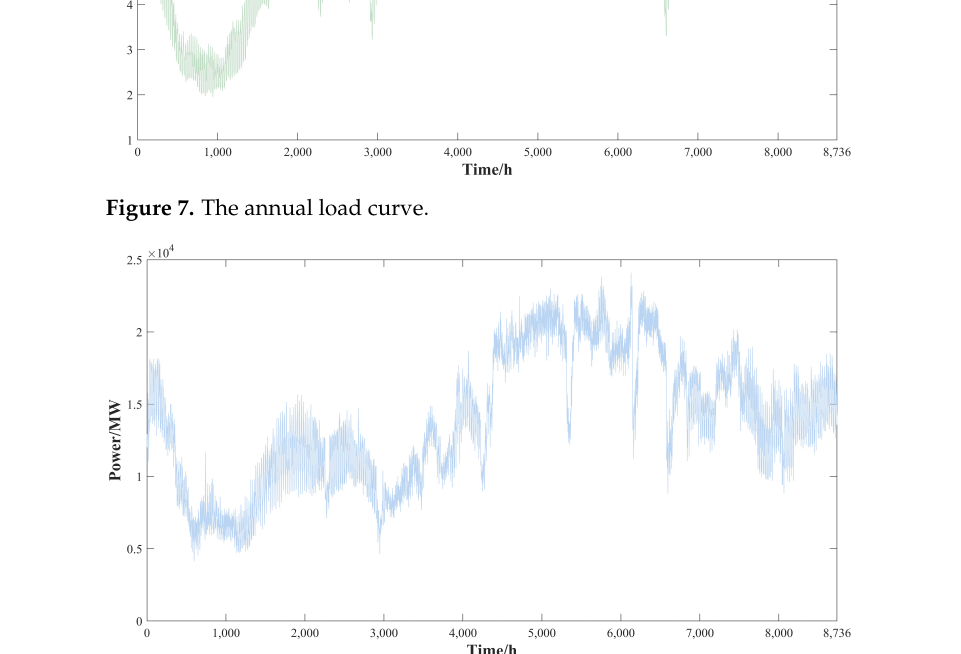
Figure 8. The annual power curve of tie